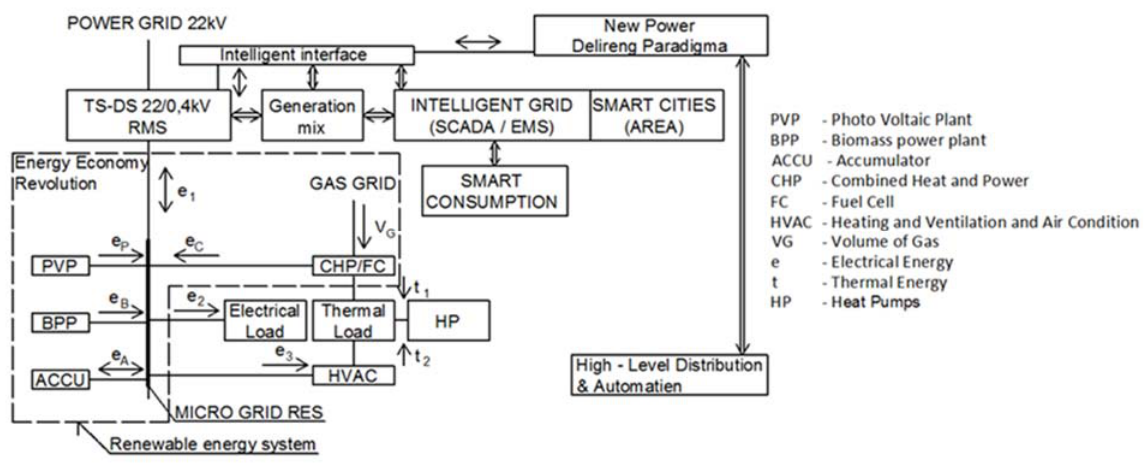
Figure 10. Local micro ‐ network of RES in the smart network system. Table 2. RES Parameters by Individual Building Cluster Blocks.